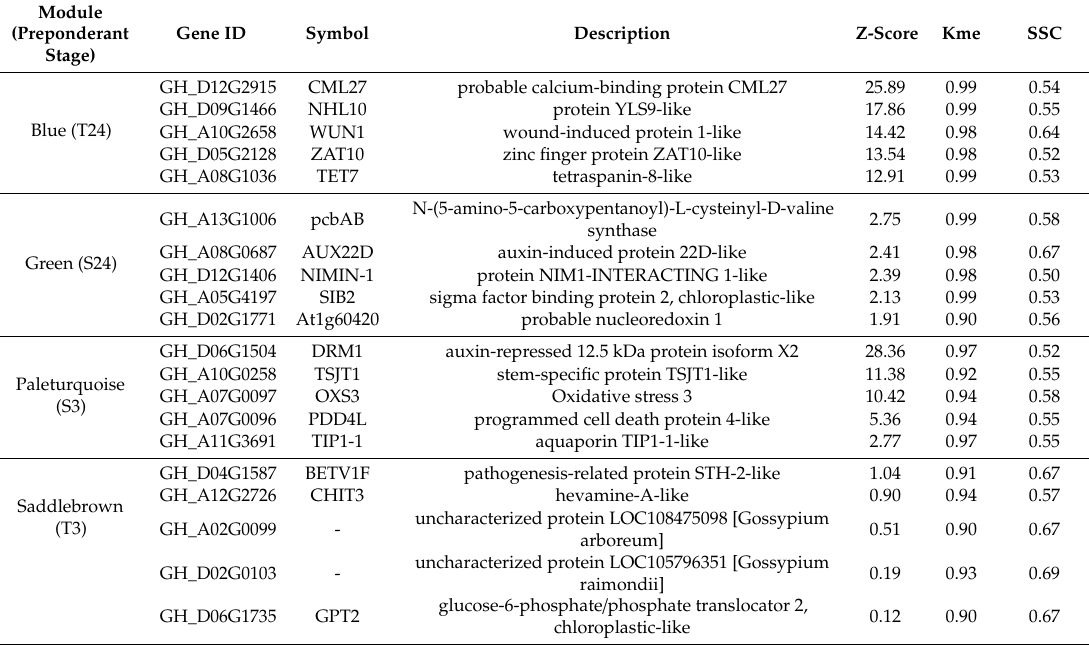
Figure 8. Coexpression network construction of the saddlebrown module. ( A ) Gene coexpression heatmap of the saddlebrown module (upper panel) and expression level of the corresponding eigengene in each sample (lower panel). ( B ) Dot plot mining hub genes with higher module connectivity and expression levels at T3. The X-axis represents the connectivity values (Kme) of genes in the saddlebrown module, while the Y-axis represents the dominant expression value (SSC T3 ) of the genes at T3. Genes with Kme > 0.8 and SSC T3 > 0.50 were identified as hub genes (saddlebrown dots). ( C ) The coexpression network of all coexpressed genes in the saddlebrown module. The node size indicated gene degree. Line thickness between nodes reflects the weight value. Table 4. The top five hub genes with high Z-score value in the dominant expression period of each module.